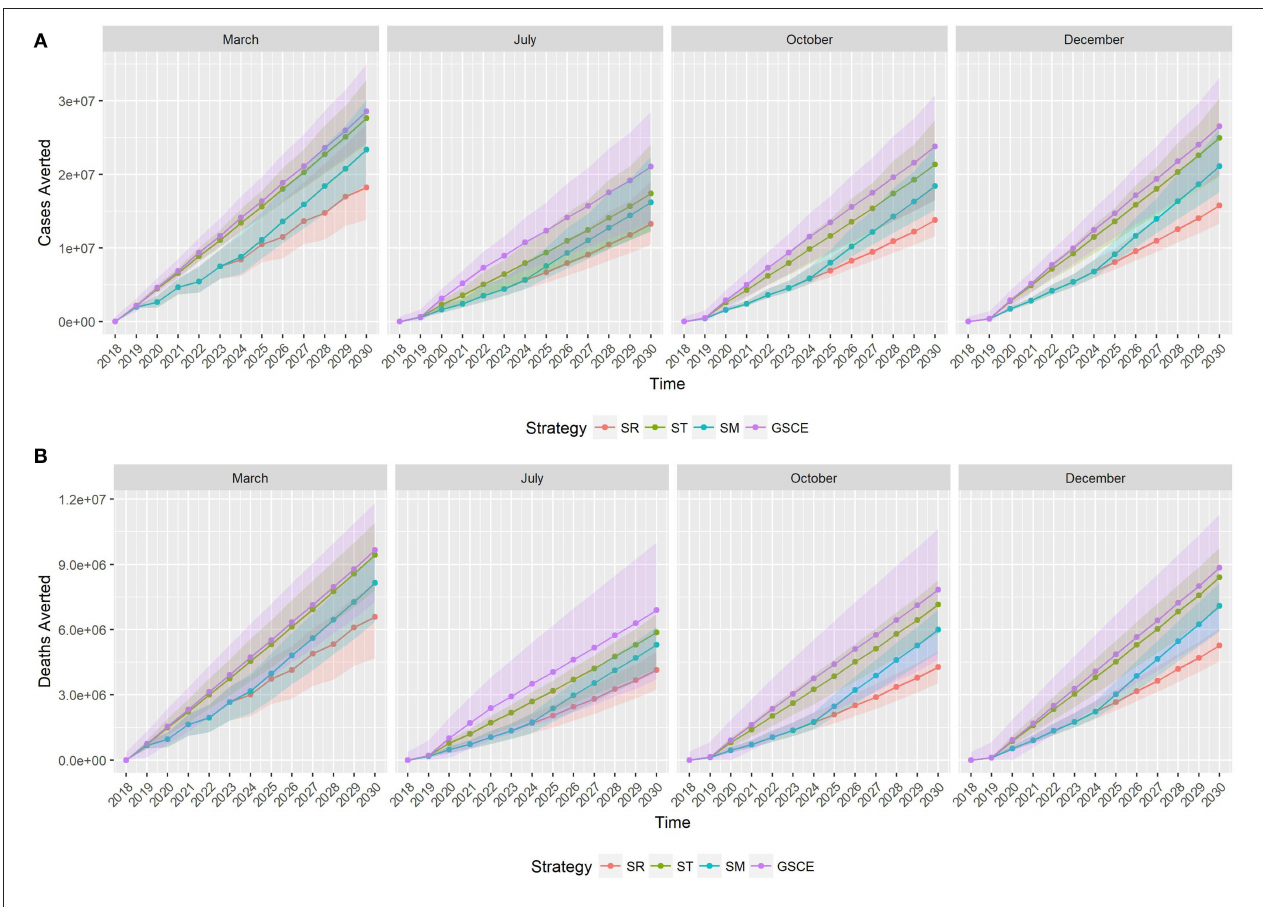
FIGURE 6 | Median cumulative number of cases (A) and deaths (B) averted by vaccination. Colors correspond to the vaccination strategy, while line type to the month of vaccination. SR, National Strategy; ST, Targeted scenario; SM, Mixed scenario (SM) and GSCE, Global Strategy for Control and Eradication.